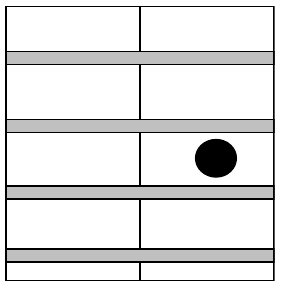
Figure 7. Application of the weight.